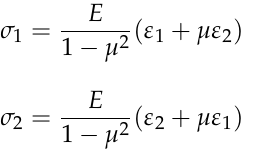
6 of 26 Figure 3. Strain gauge station, ZET 017–Tb.